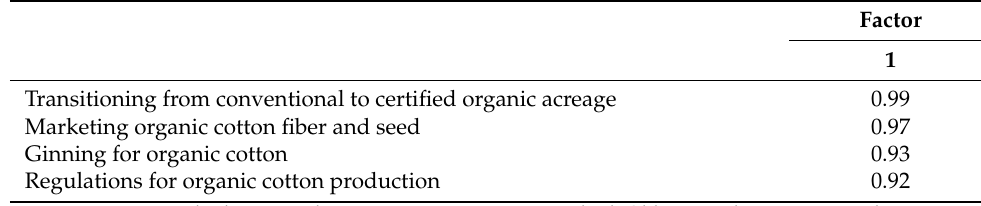
Table 18. Factors and importance items of organic cotton production competencies.